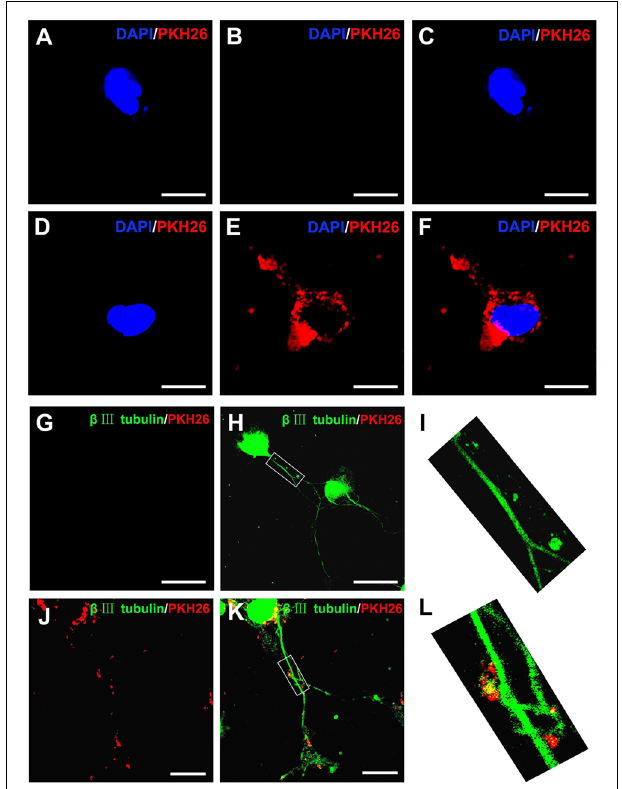
FIGURE 2 | Internalization of OECs-derived EVs by DRG neurons and axons. Notes: the obtained OECs-EVs were labeled by PKH26 (red) and DRG neurons were immunofluorescent stained for β -tubulin III (green) with DAPI nuclear counterstaining (blue). Representative images showed no EVs in the cytoplasm and axons of DRG neurons (A–C,G–I) in the control groups, while labeled EVs (red) can be found within the cytoplasm and axons of DRG neurons in the OECs-EVs treated groups (B–F,J–L) . Scale bars: (A–F) 10 µ m; (G,H) 50 µ m; (J,K) 25 µ m. Abbreviations: OECs, olfactory ensheathing cells; EVs, extracellular vesicles; DRG, dorsal root ganglion; GFAP, glial fibrillary acidic protein; DAPI, 4 (cid:48)